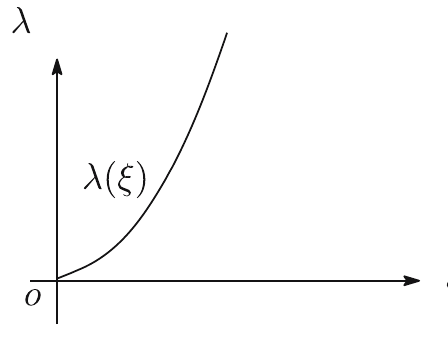
Figure 1: The graph of λ ξ ( ) for p 0 1 < <